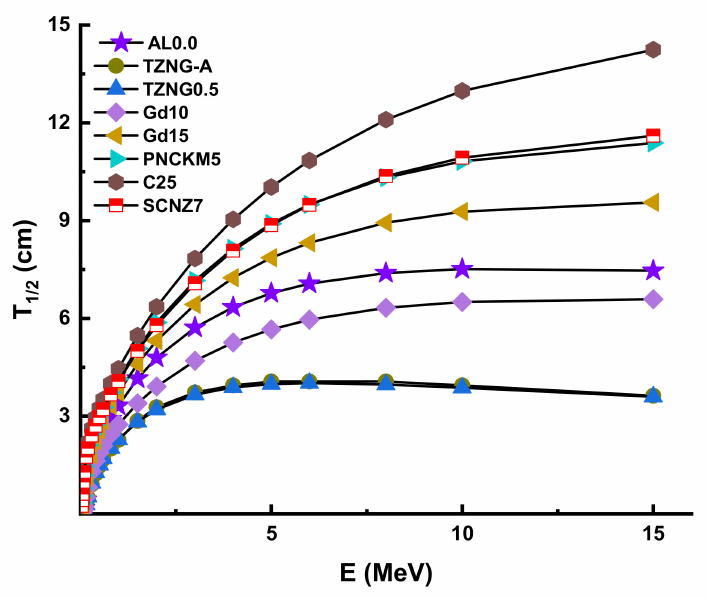
Figure 13. Half-value layer comparison between some glasses and AL0.0 sample.